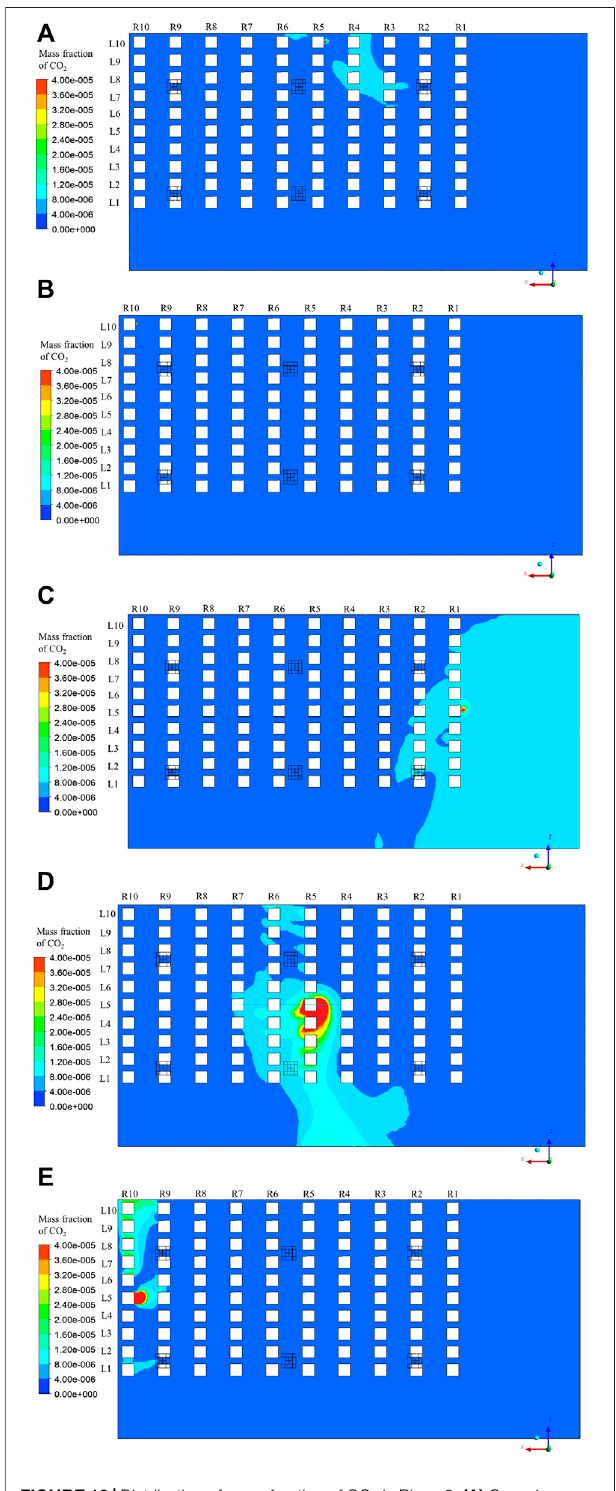
FIGURE 10 | Distribution of mass fraction of CO 2 in Plane 3: (A) Case 4; (B) Case 5; (C) Case 6; (D) Case 7; (E) Case